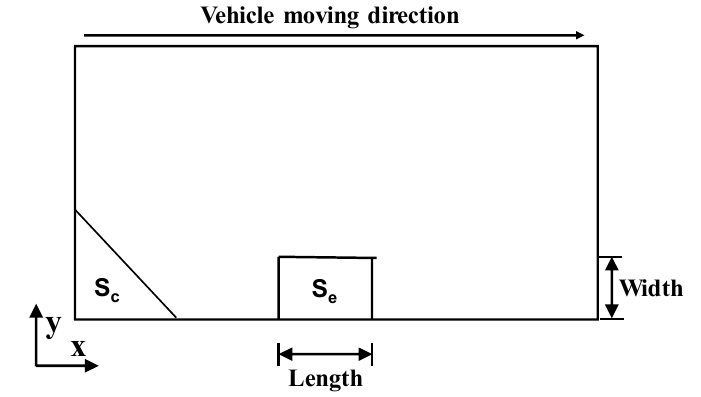
Figure 3. Void morphology of the FEA model.